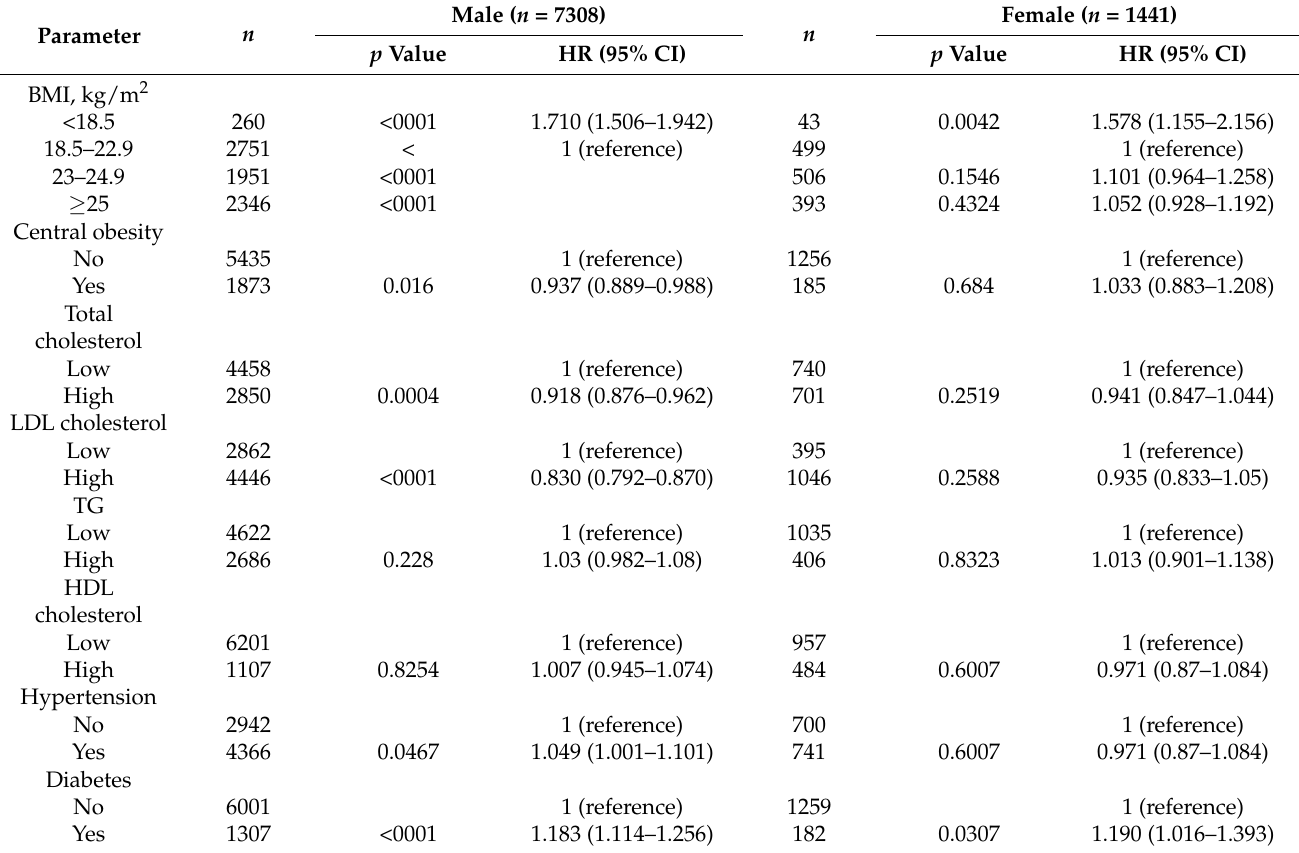
Table 3. Hazard ratio of head and neck cancer risk by sex according to each